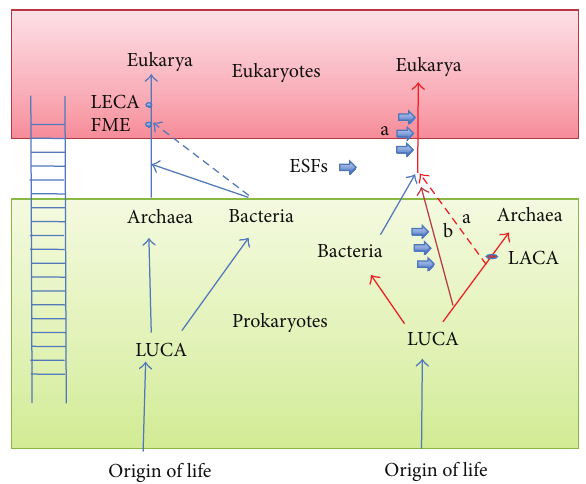
Figure 1: The Aristotle scenarios. (a) The traditional ladder-like evolutionary scenario, in which organisms increased in complexity from the origin of life to prokaryotes and eukaryotes, with archaea being intermediate organisms on the way to become eukaryotes; (b) the classical universal tree of life of Woese et al. [53] in red, combined with the fusion hypothesis (blue line). The LECA is the last eukaryotic common ancestor and FME the first eukaryote harbouring mitochondria; the dotted line refers to the hypothesis in which eukaryotes originated by the association of an archaeon with the mitochondrial bacterial ancestor [49]. Thick arrows indicate the emergence of eukaryotic specific features